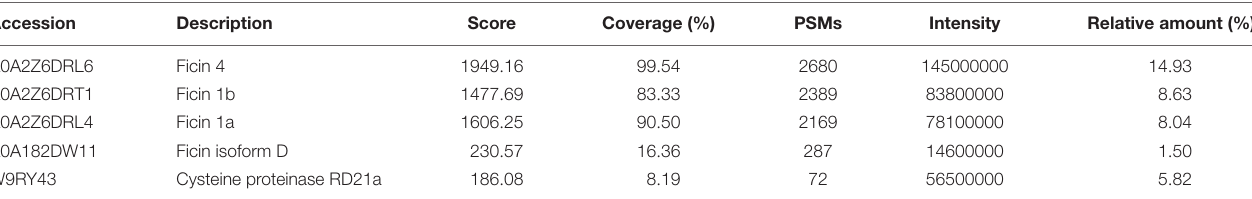
TABLE 4 | Papain-like cysteine proteases identified in the commercial-ripe fig fruit receptacle latex